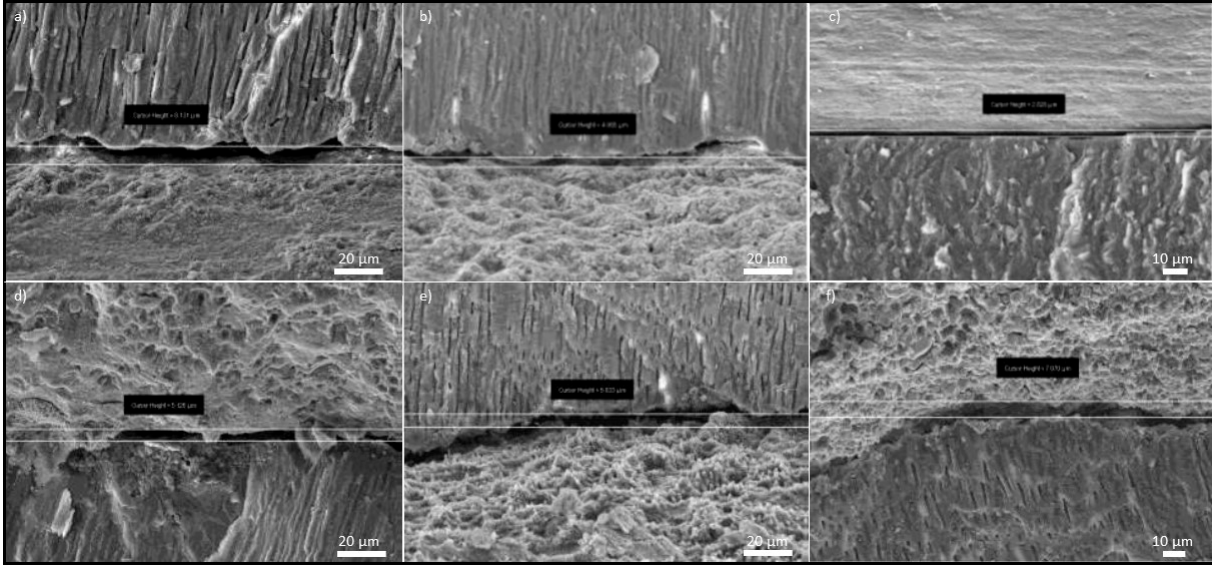
Figure 16. Leaks on the border of the sealant and dentin of the root canal filled with the THC thermoplastic condensation method with a width of: ( a ) 8.131 µm; ( b ) 4,065 µm; ( c ) 1.061 µm; ( d ) 5.126 µm; ( e ) 5,833 µm; ( f ) 7,070 µm, viewed with SEM.